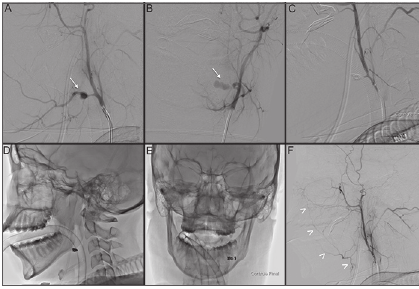
Figure 1. A and B: Left external carotid angiography (lateral and AP projections) showing a pseudoaneuryms of the linguo- facial trunk (arrows); C: Final control after internal trapping; D and E: Cast of coils; F: Retrograde filling of linguofacial vascular territory via internal maxillary artery anastomosis